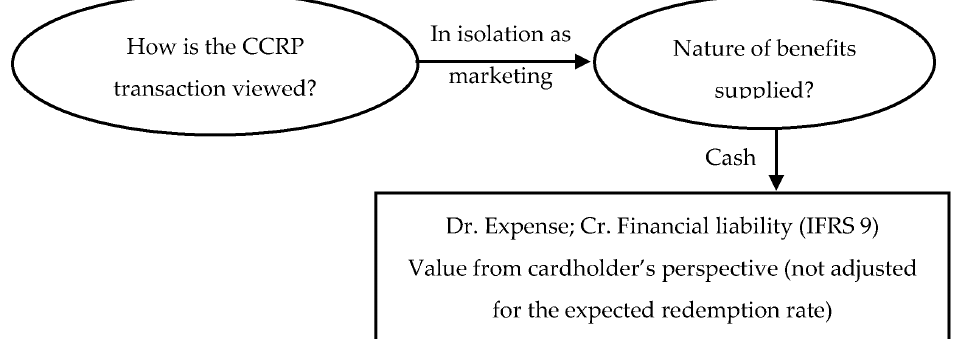
Figure 2. Accounting for a CCRP transaction viewed as a marketing tool when nature of benefits is cash.